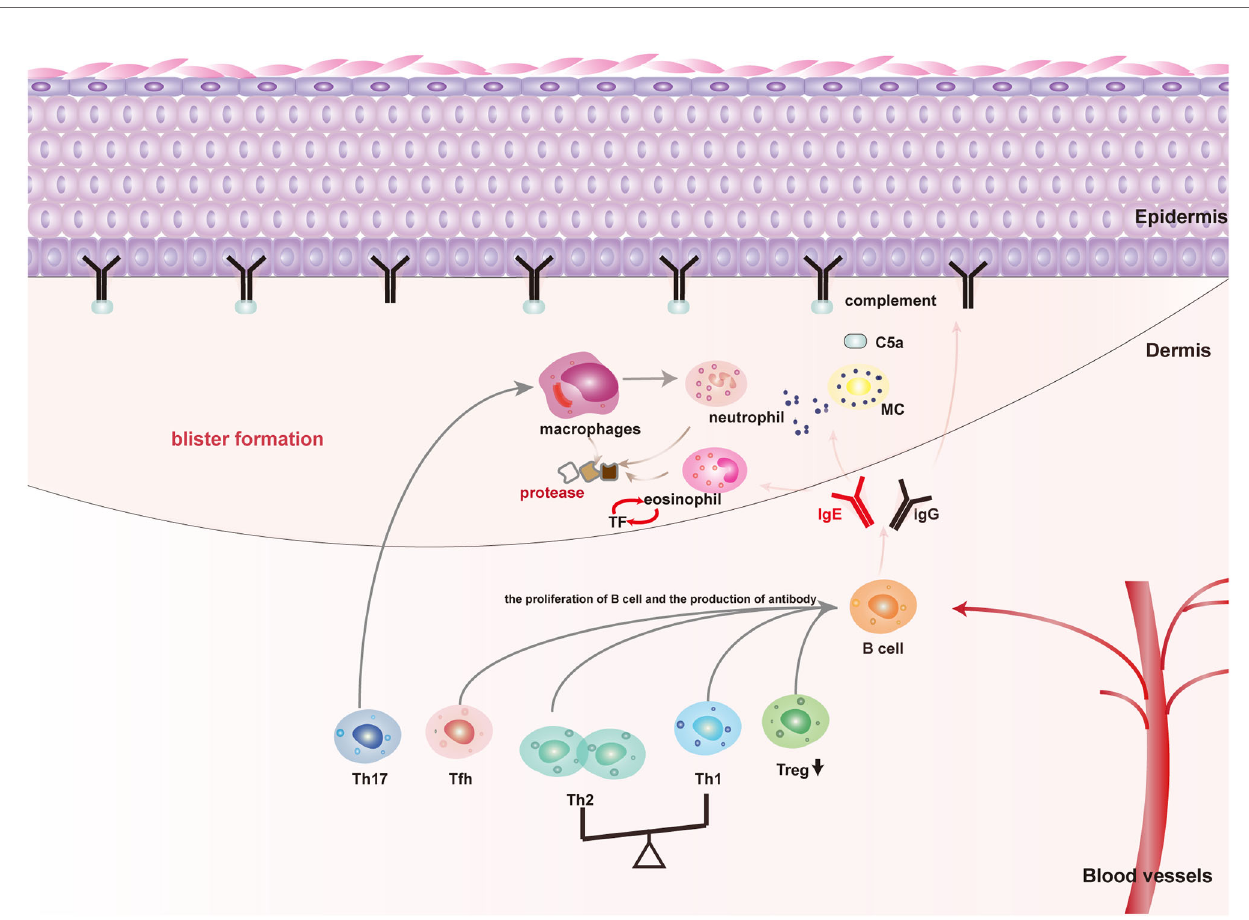
FIGURE 1 | The main pathogenic mechanism of blister formation in patients with BP: Autoimmune abnormalities such as dysfunction of Th cells and Treg cells lead to the production of anti-BP180 autoantibodies, among which BP180IgG and IgE are the main pathogenic antibodies for blister formation. (1) Mechanical damage: Both BP180IgG and IgE could bind to the NC16A domain of BP180, resulting in BP180 internalization, thus decreasing the adhesion; (2) In fl ammatory injury: BP180IgG and IgE could also activate keratinocytes to release IL-8 and other cytokines by binding to BP180. Moreover, BP180IgG and IgE also activate mast cells in a complement-dependent or independent way to release cytokines and mMCP-4. These above cytokines and mMCP-4 recruit and activate in fl ammatory cells dominated by eosinophils and neutrophils to magnify the in fl ammatory response of skin lesions and cause tissue damage; (3) Speci fi c pathways of mast cell activation: BP180IgG and IgE directly activate mast cells by binding to Fc g R or Fc ϵ R of mast cells. BP180IgG binding BP180 also activate the complement cascade pathway to produce C5a, which binds to the C5aR of mast cells and indirectly causes mast cell